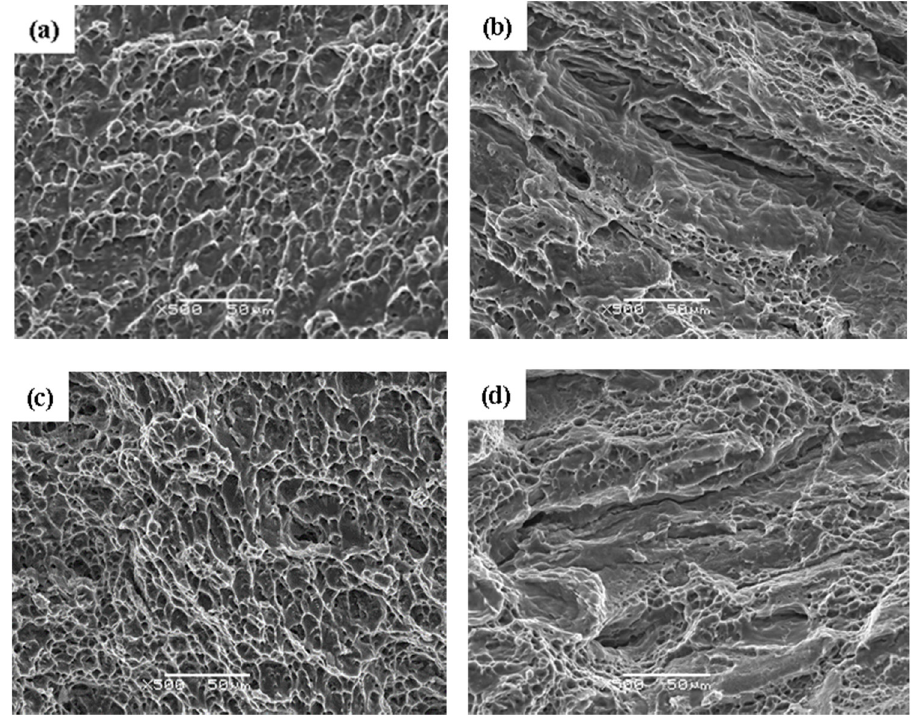
Figure 8: Scanning images of tensile fractures of joints under di ff erent conditions: ( a ) AW joint, ( b ) HT1 joint, ( c ) HT2 joint, and ( d ) HT3